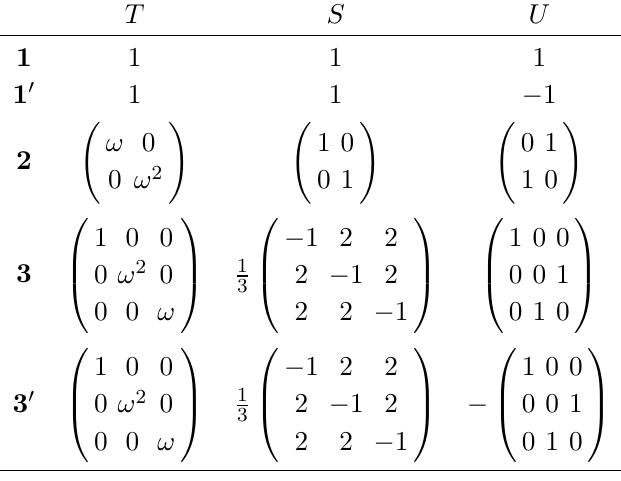
Table 2 . The representation matrices for the S 4 generators T , S and U , where ! = e 2 (cid:25)i= 3 .